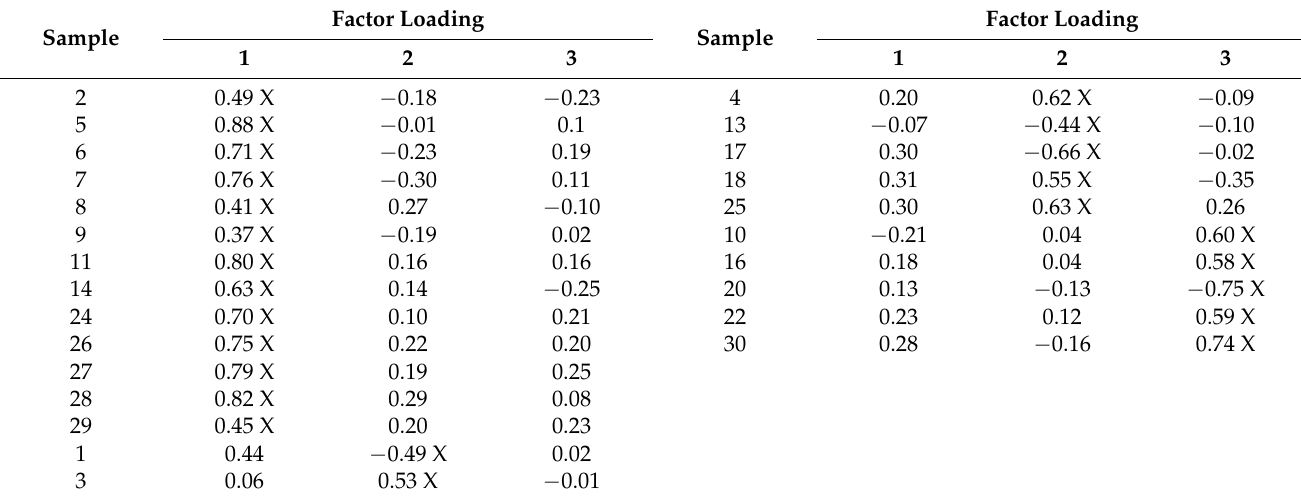
Table 4. Factor load table.